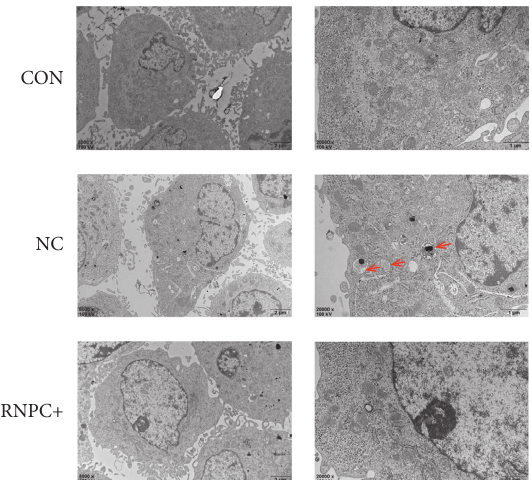
Figure 8: The effect of overexpression of HNRNPC on autophagy in PC12 cells. The red arrow in the figure is the autophagosome. CON: control group, NC: empty plasmid group, HNRNPC+: overexpression HNRNPC